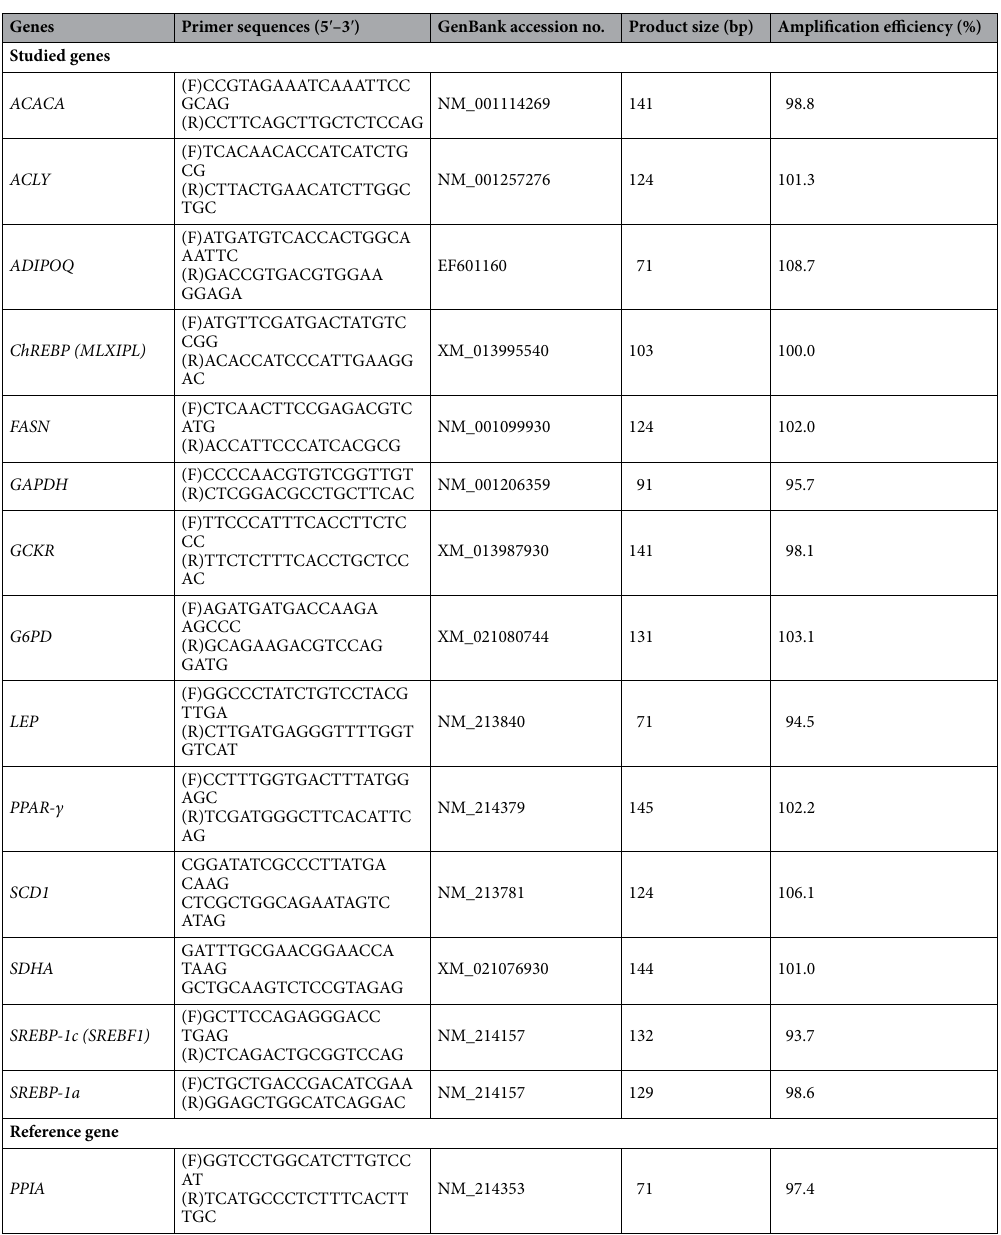
Table 2. Primer sequences used for real-time PCR amplifications of studied genes. ACACA acetyl CoA carboxylase alpha, ACLY ATP citrate lyase, ADIPOQ adiponectin, ChREBP (MLXIPL) MLX interacting protein like, FASN fatty acid synthase, GAPDH glyceraldéhyde-3-phosphate dehydrogenase, GCKR glucokinase regulator, G6PD glucose-6-phosphate dehydrogenase, LEP leptin, PPAR-γ peroxisome proliferator activated receptor gamma, PPIA peptidylpropyl isomerase A, SCD1 stearoyl-CoA desaturase, SDHA succinate dehydrogenase complex flavoprotein subunit A, SREBP-1c (SREBF1) sterol regulatory element binding